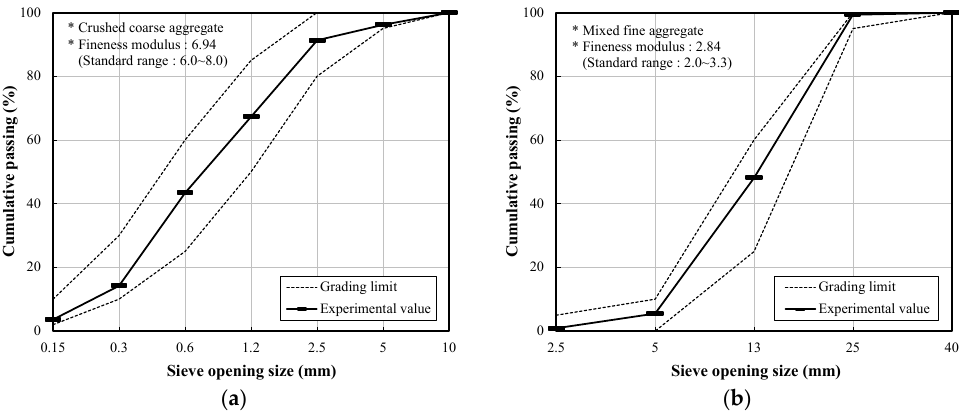
Figure 3. Gradation sieve analysis curves of the aggregates: ( a ) mixed fine aggregates; ( b ) coarse aggregates.